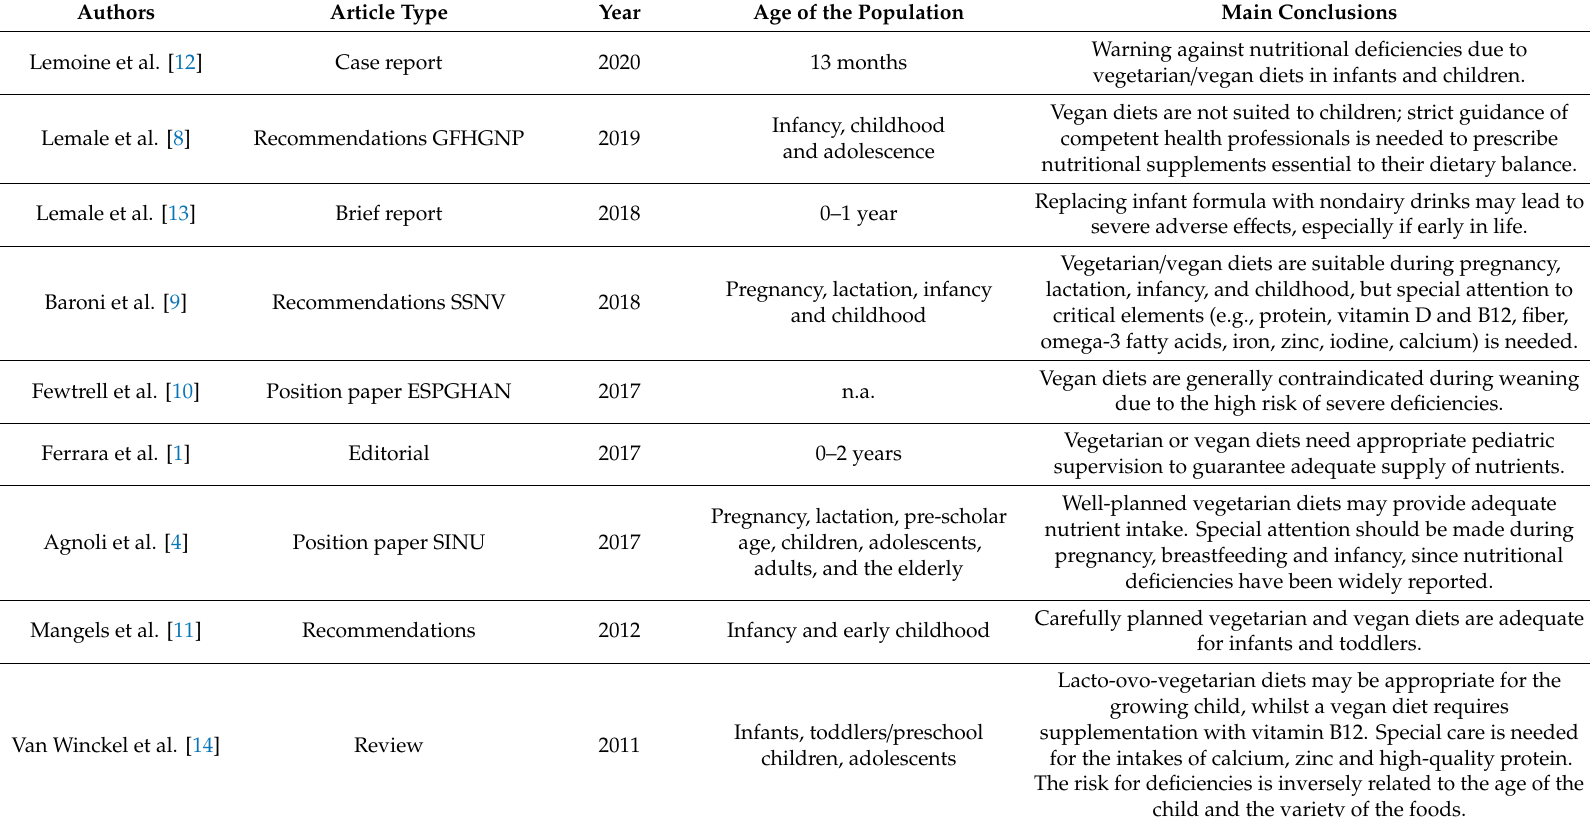
Table 4. Studies included in the narrative